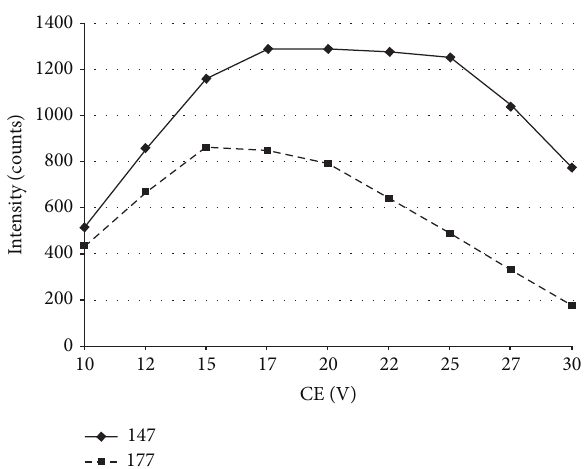
Figure 5: Plot of abundances of ions at 𝑚/𝑧 147 and 𝑚/𝑧 177 versus CE.